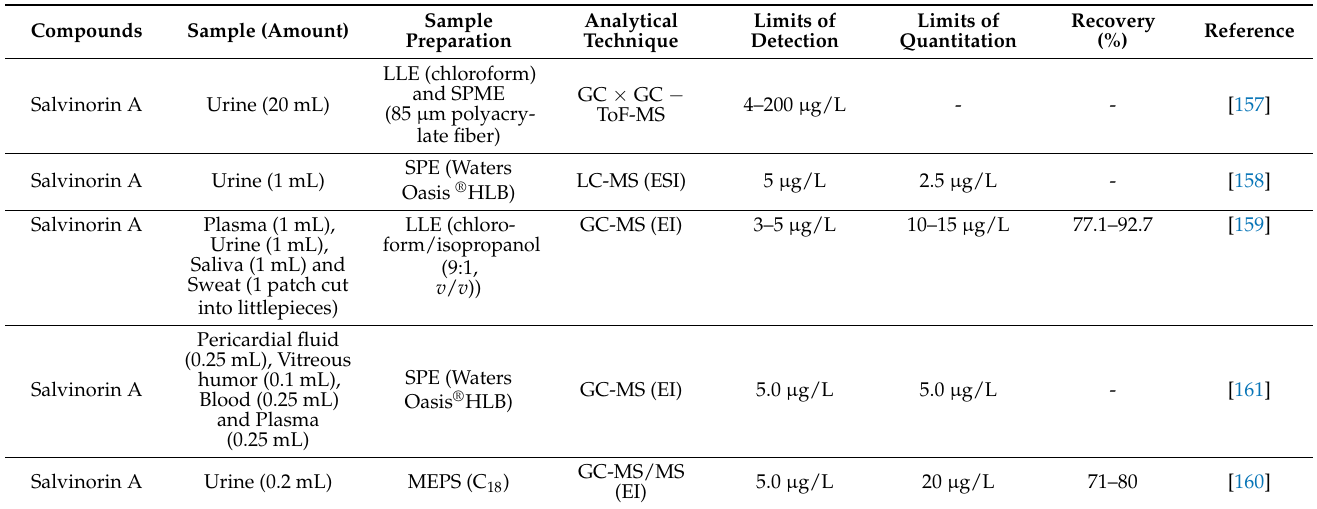
Figure 11. S. divinorum ( A ) and the main compounds salvinorin A ( B ) and salvinorin B ( C ). Table 8. Analytical methods for the determination of the main components of Salvia divinorum